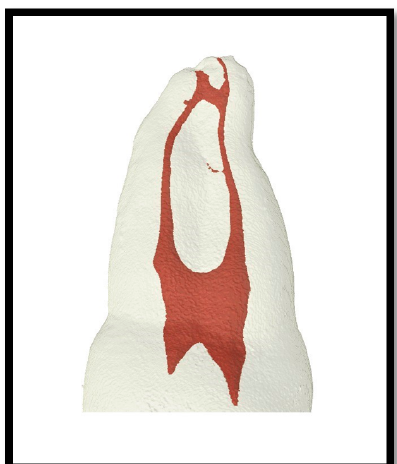
Figure 6. Micro-CT image showing Vertucci’s type VI (2-1-2) canal configuration.